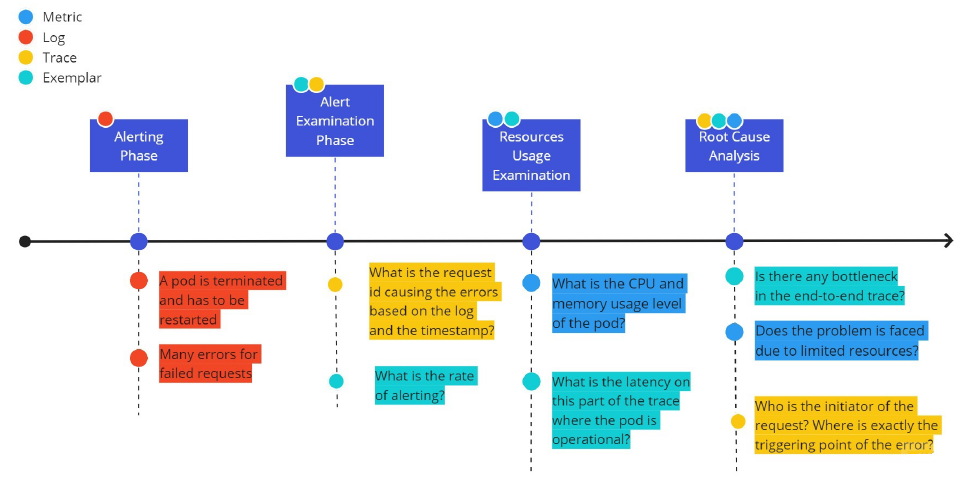
Figure 2. Exemplar usage